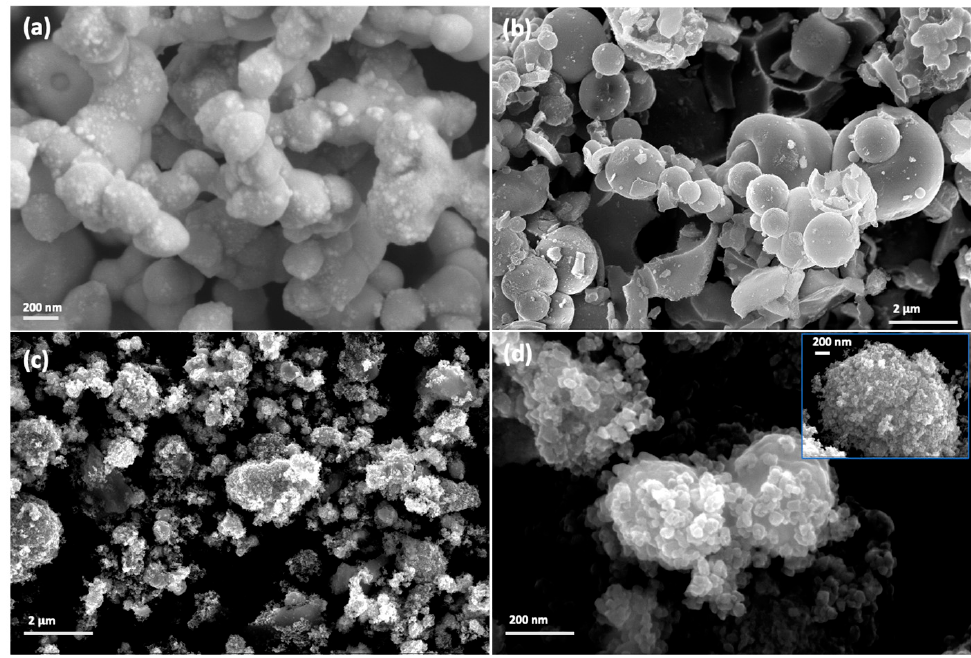
Figure 2. SEM images of ( a ) Ag 3 PO 4 , ( b ) TS82, ( c ) TS82-AgP16 and ( d ) higher magnification image of TS82-AgP16.